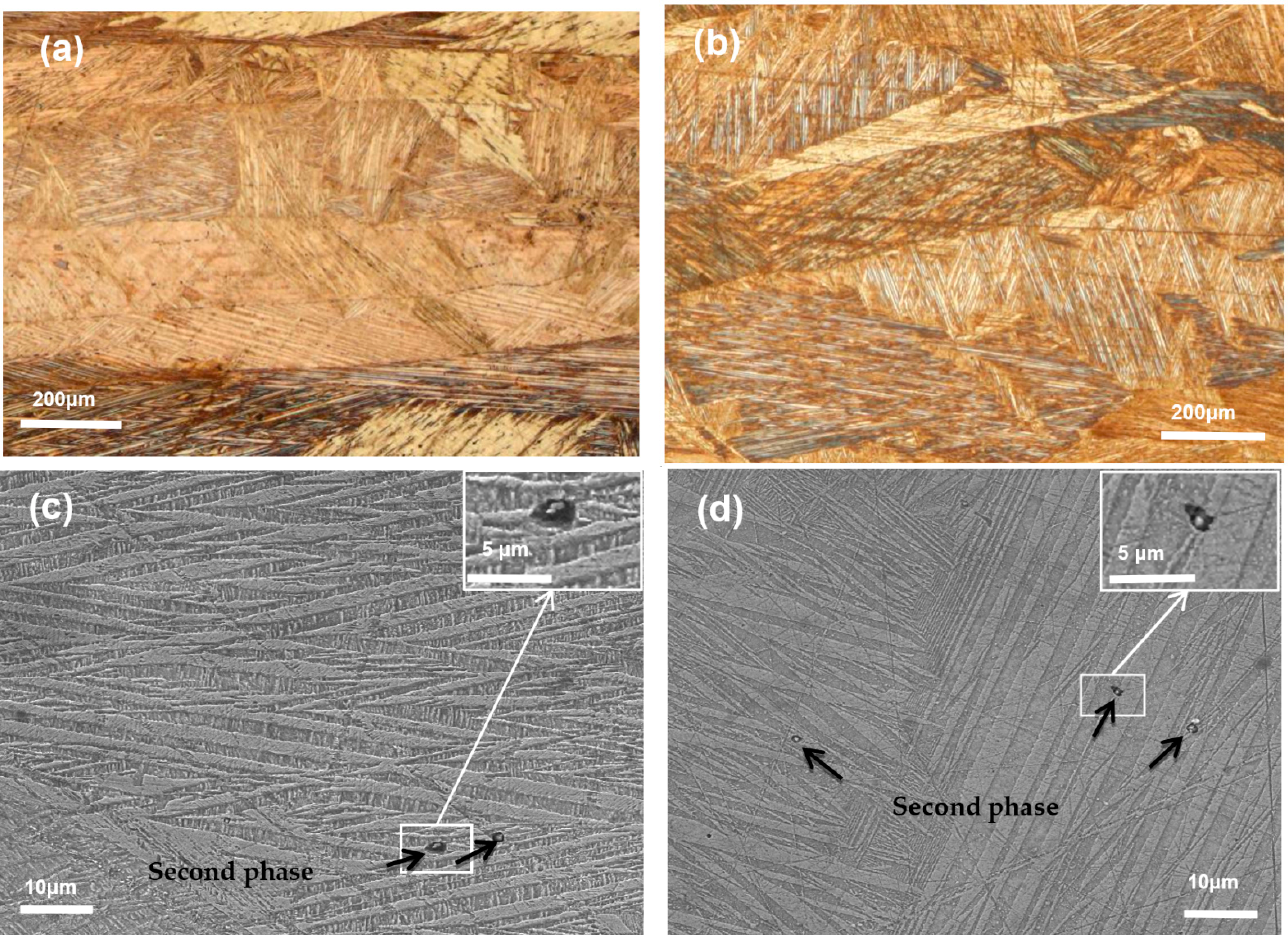
Figure 1. Metallographic photo of Cu-13.0Al-4.0Ni- x Sm ( x = 0.2 ( a ), 0.5 ( b )) alloys and SEM micrograph of Cu-13.0Al-4.0Ni- x Sm ( x = 0.2 ( c ), 0.5 ( d )) alloys, the illustration in ( c , d ) is a partial enlarged view of the box part.